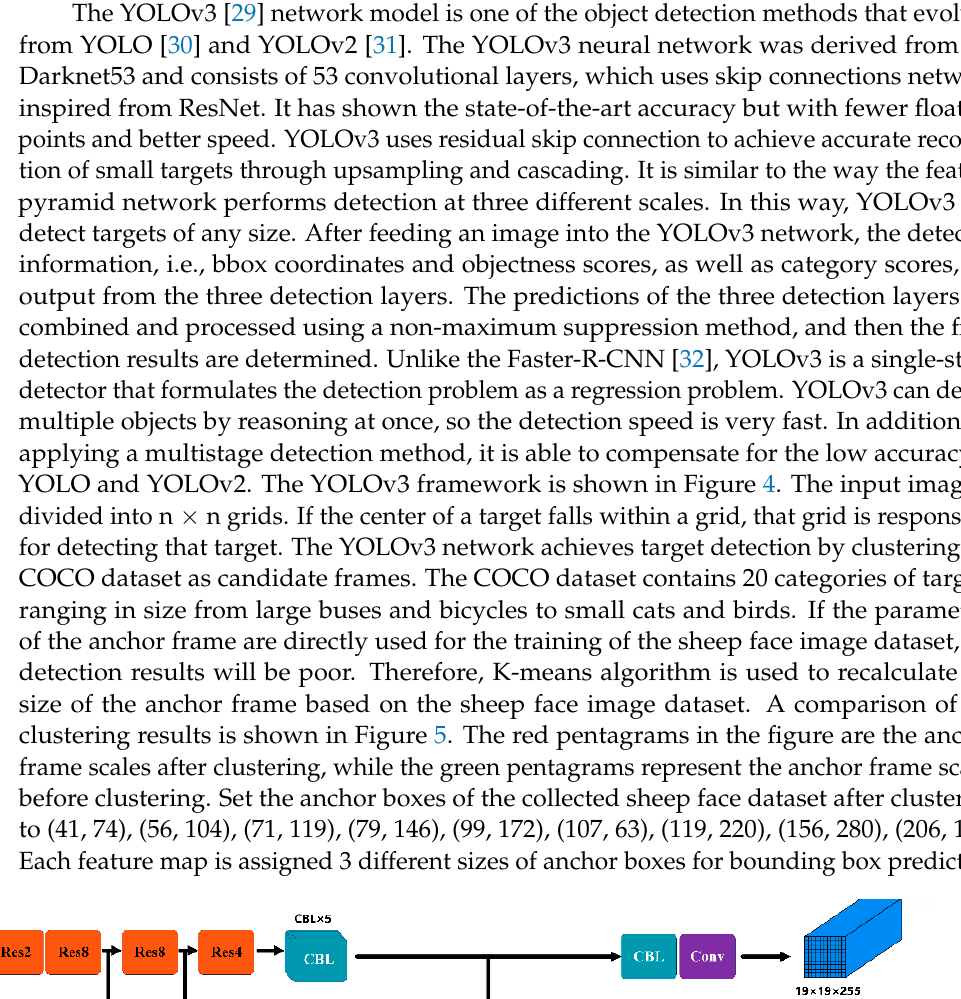
Figure 5. Clustering results of anchor boxes. 3.3. Compress the Model by Pruning YOLOv3 has a greater advantage in sheep face recognition accuracy compared with other target detection networks, but it is still difficult to meet the requirements of most embedded devices in terms of model size. Therefore, model compression is needed to re- duce the model parameters and make it easy to deploy. The methods of model compres- sion are divided into pruning [33,34], quantization [35,36], low-rank decomposition [37,38] and knowledge distillation [39,40]. Pruning has become a hot research topic in ac- ademia and industry because of its ease of implementation and excellent results. Fan et al. simplify and speed up the detection by using channel pruning and layer pruning methods for the YOLOv4 network model. This reduces the trimmed YOLOv4 model size and in- ference time by 241.24 MB and 10.82 ms, respectively, The mean average precision (mAP) also improved from 91.82% to 93.74% [41]. A pruning algorithm combining channel and layer pruning for model compression was proposed by Lv et al. The results show a 97%